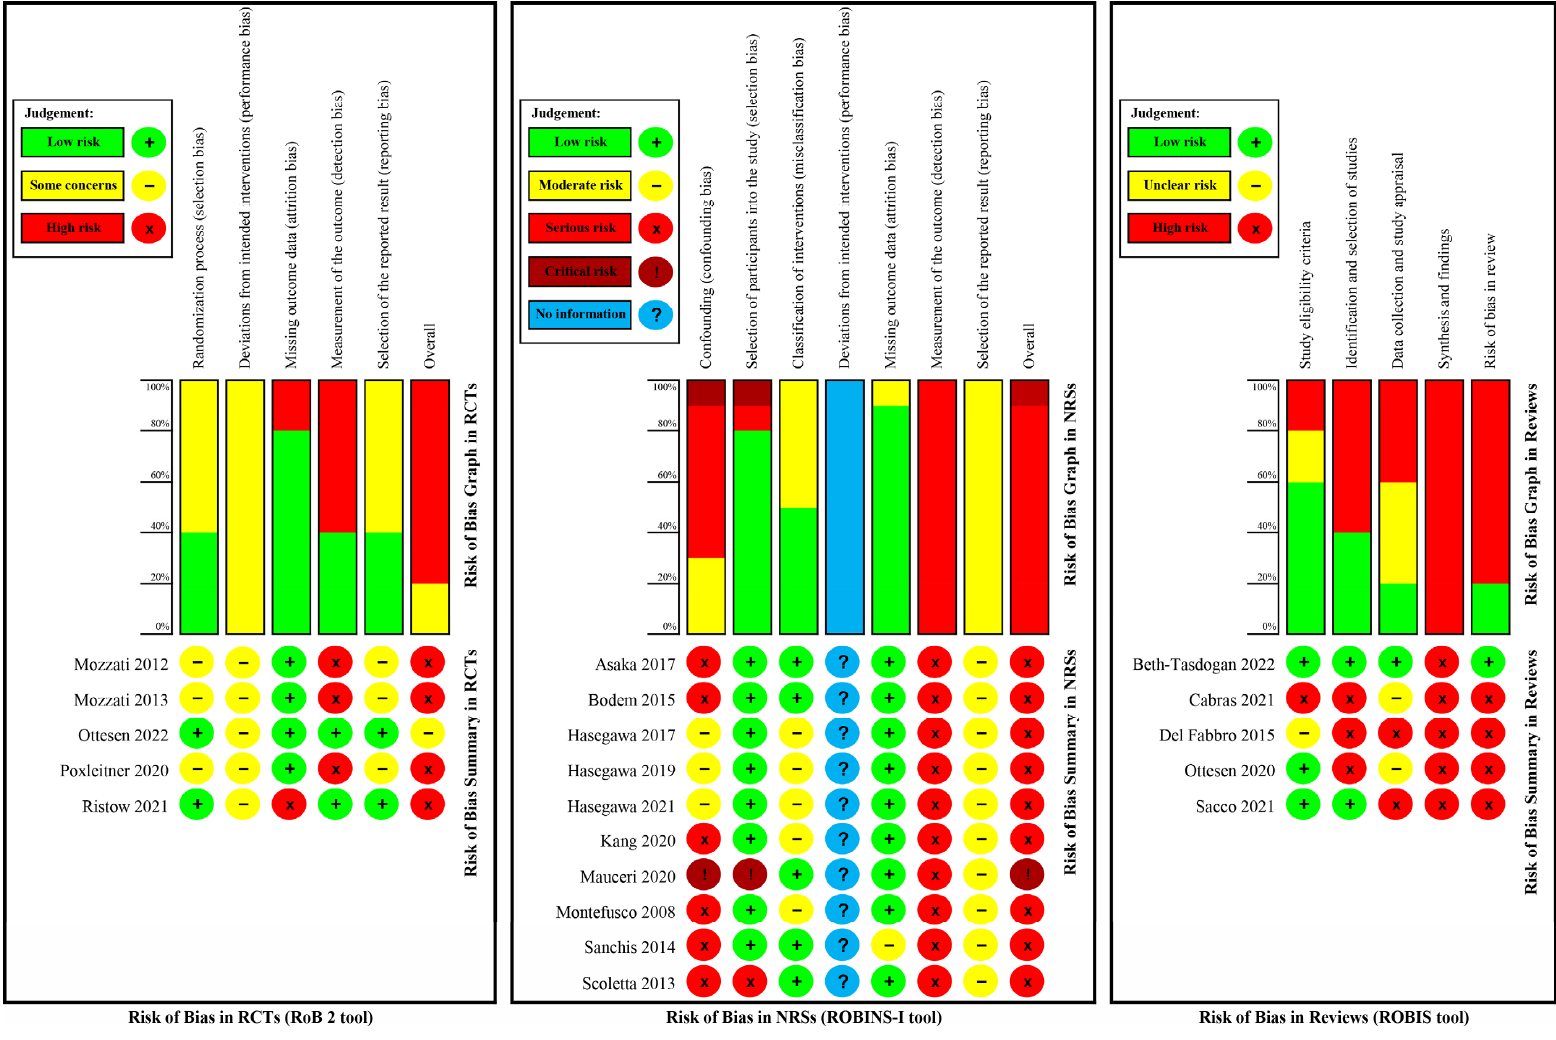
Figure 4. Risk of bias assessment in this evidence mapping review [15,16,24–40].